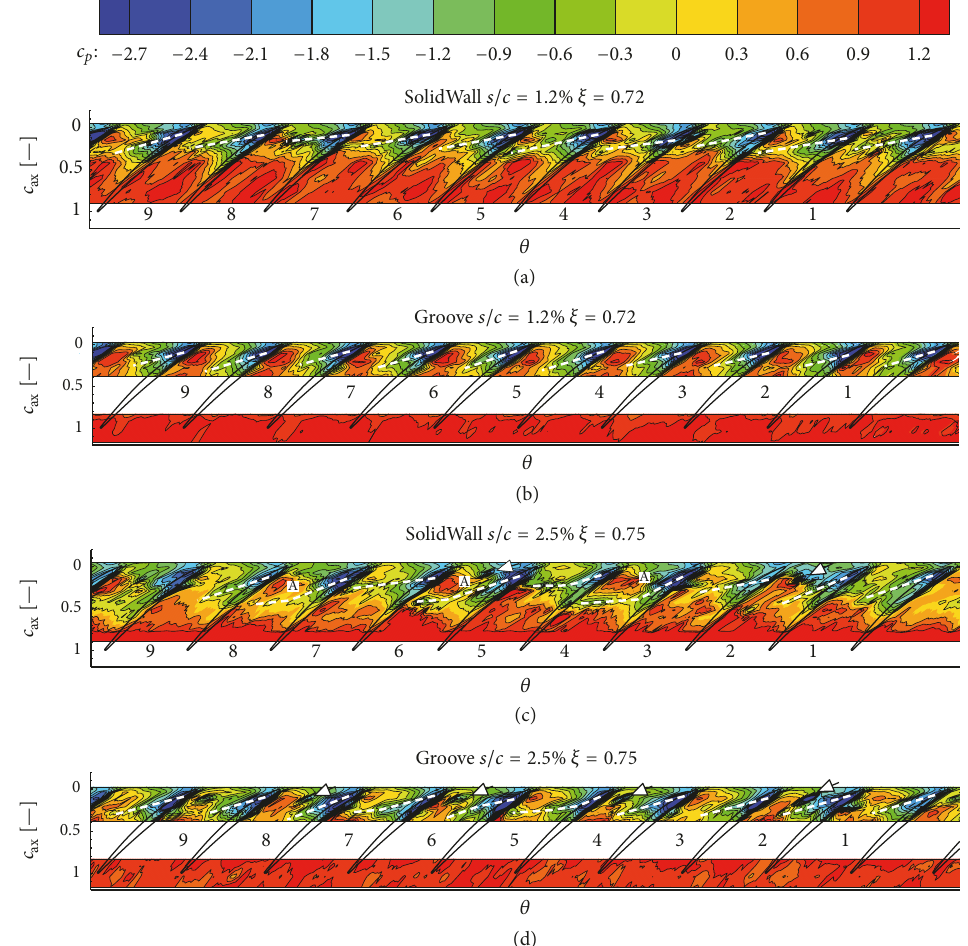
Figure 9: Time-resolved casing static pressure over rotor for SolidWall and Groove at 𝑠/𝑐 = 1.2% (a, b) and 𝑠/𝑐 = 2.5% (c, d). SolidWall operating points are near stall, Groove operating points identical to